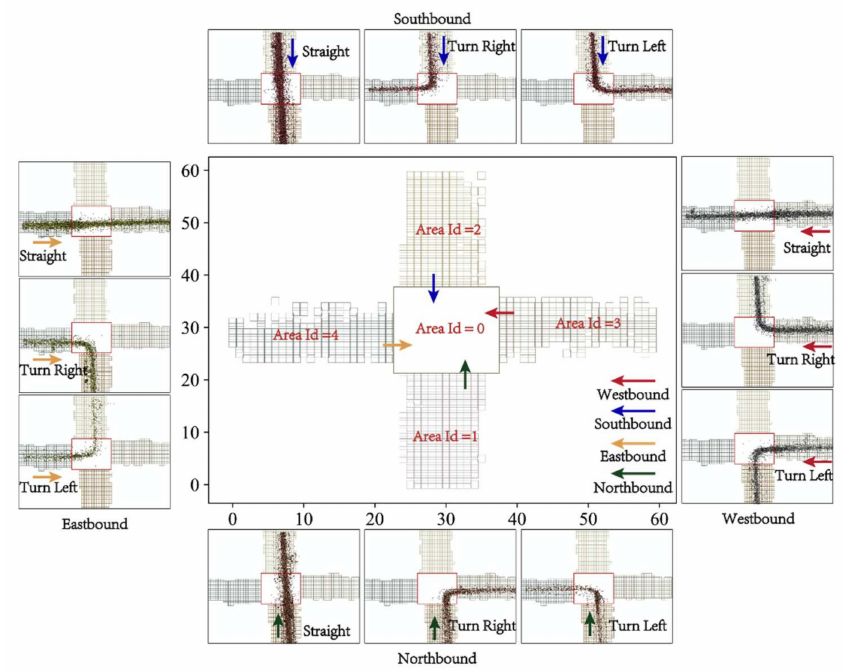
Figure 5. Identified the direction of the trajectory.